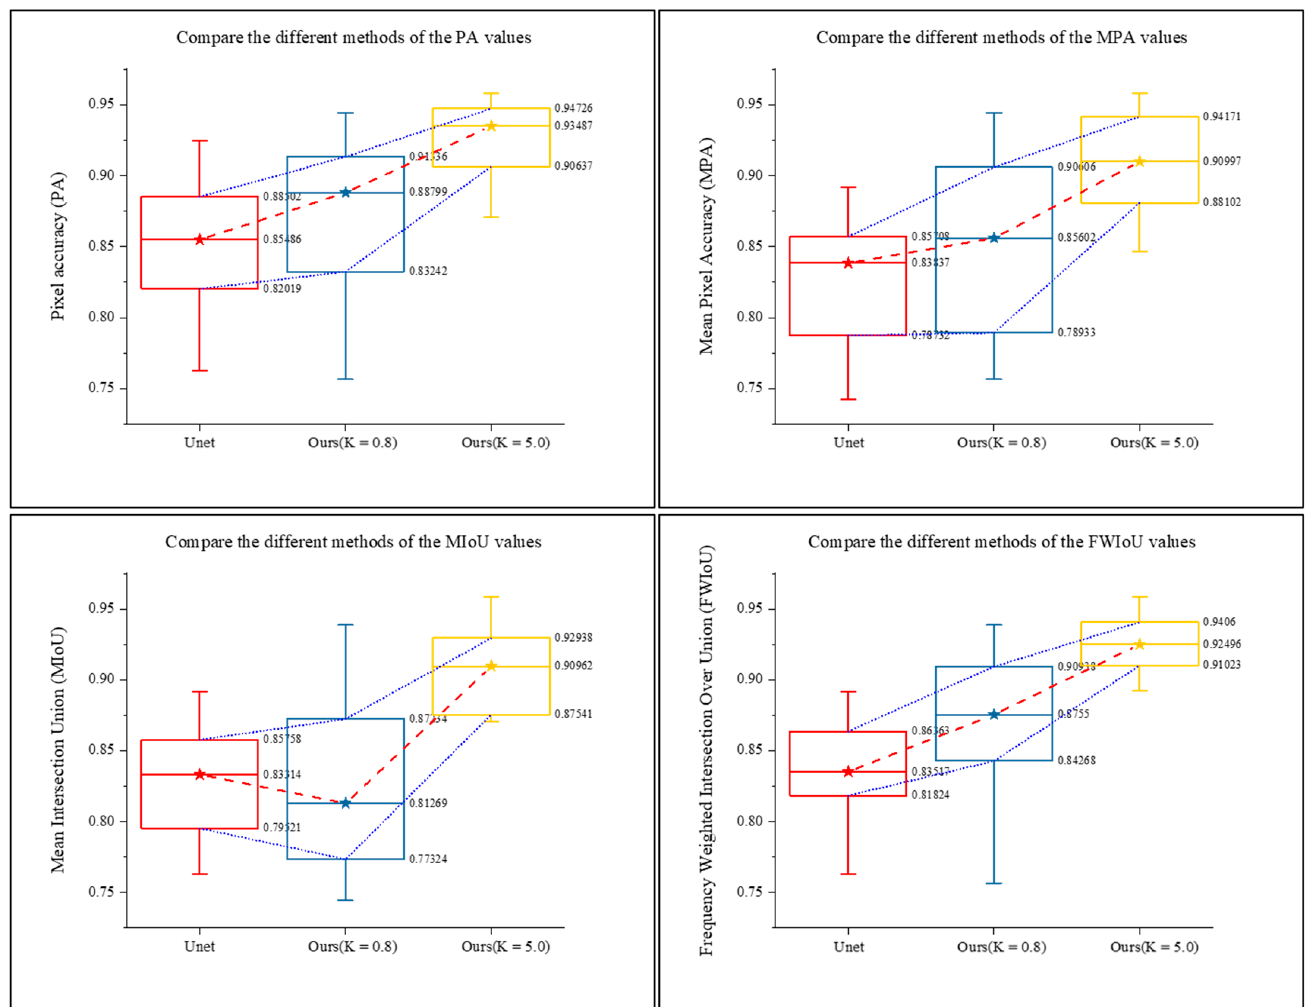
Figure 10. Image segmentation datasets for the verification of proposed OISM and Unet models (the star is the median value of the box plot) .